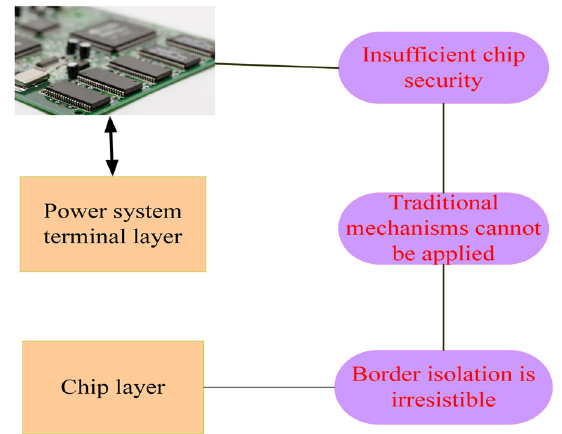
Figure 3: Security challenges of grid